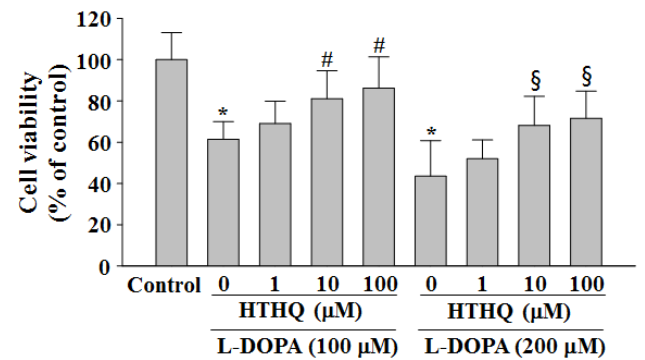
3,4- L -dihydroxyphenylalanine ( L -DOPA)-induced cell viability in PC12 cells. PC12 cells were